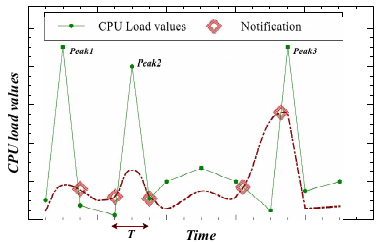
Figure 5. Threshold calculation for the peak